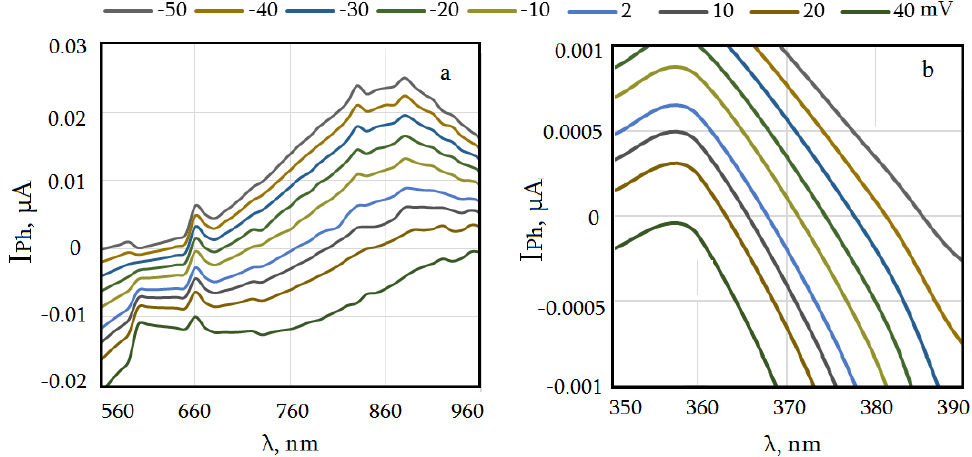
Figure 3. The change in the spectral photocurrent of DPB photodetector samples sign in the long-wave ( a ), and short-wave ( b ), regions at different bias voltages (in mV).